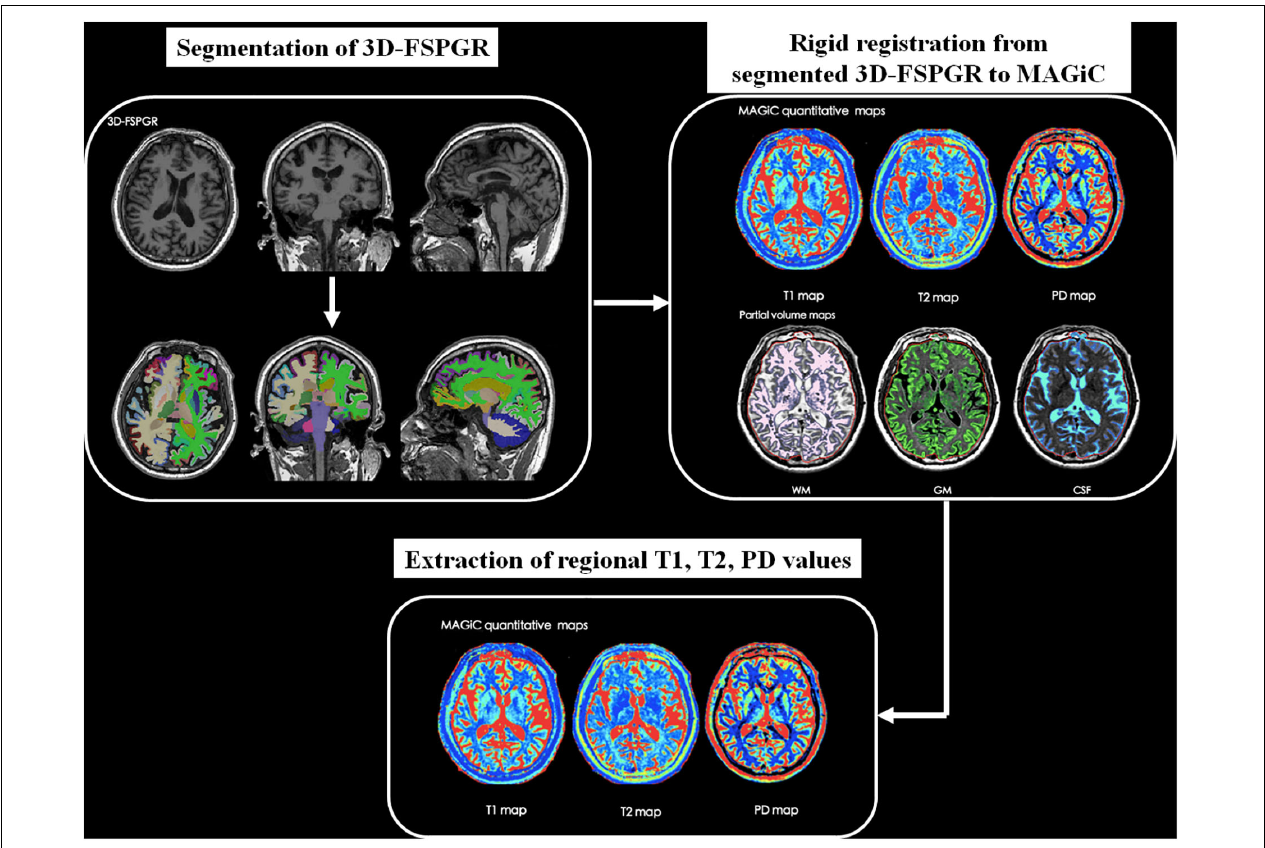
FIGURE 1 | The schematic diagram of post-processing and measurements of synthetic MRI data.